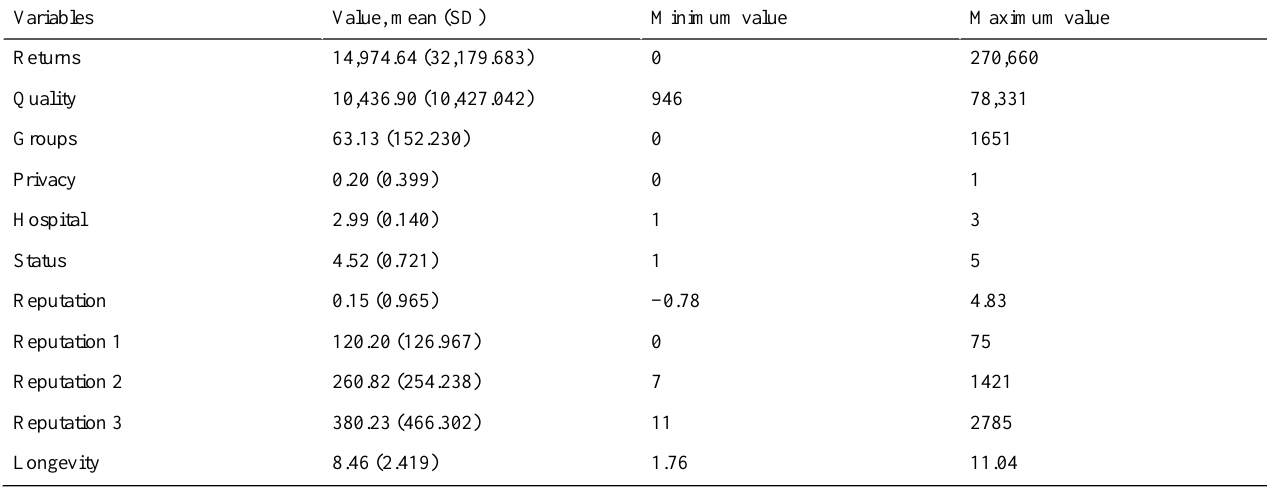
Table 2. Results for descriptive